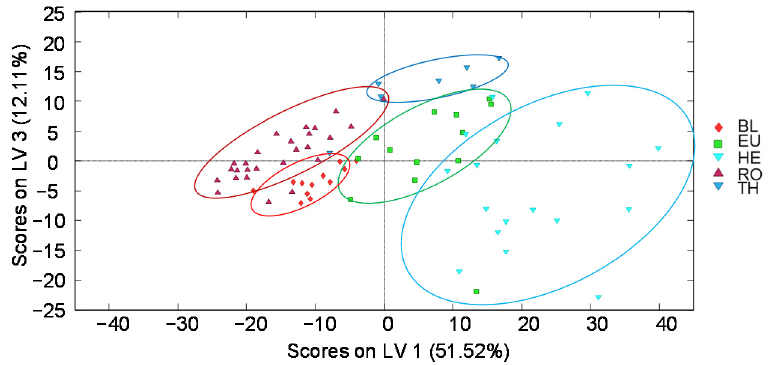
Figure 7. PLS-DA score plot of LV1 vs. LV3 when using off-line SPE HPLC-UV polyphenolic fingerprints (at 280 nm) as honey chemical descriptors of blossom honeys for botanical origin classification (4 LVs were used to build the model). BL: Orange/lemon blossom; EU: Eucalyptus; HE: Heather; RO: Rosemary; TH: Thyme.